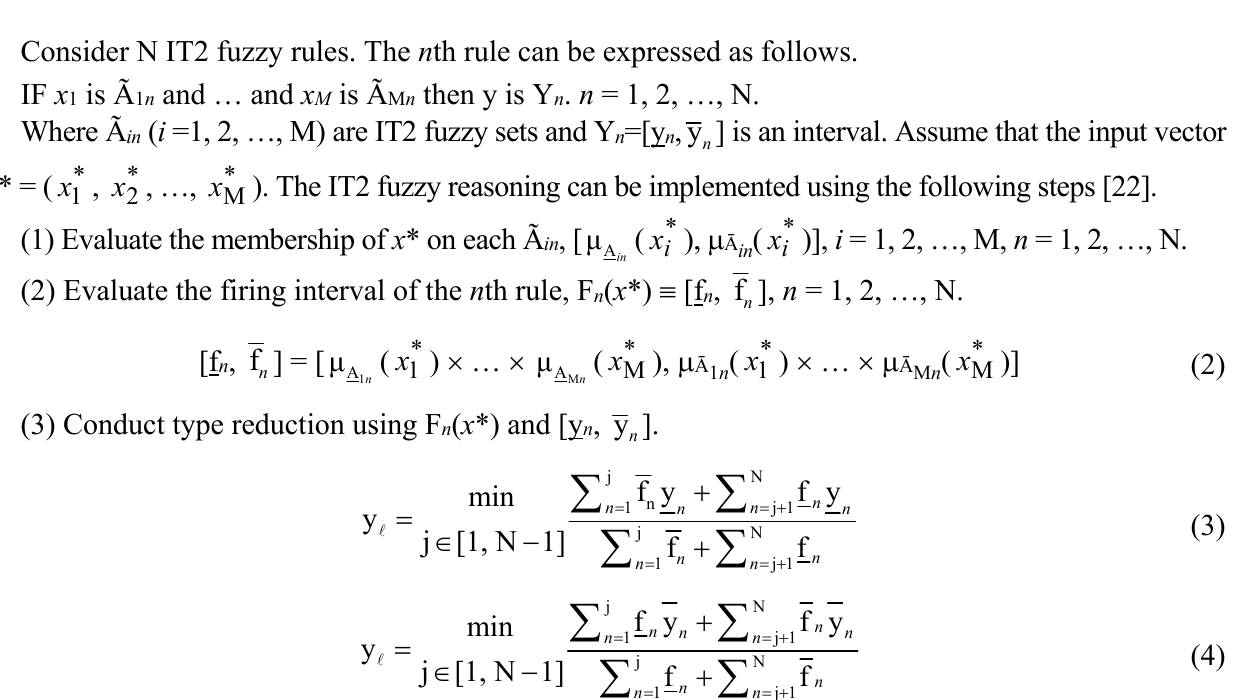
Figure 2. IT2 fuzzy logic